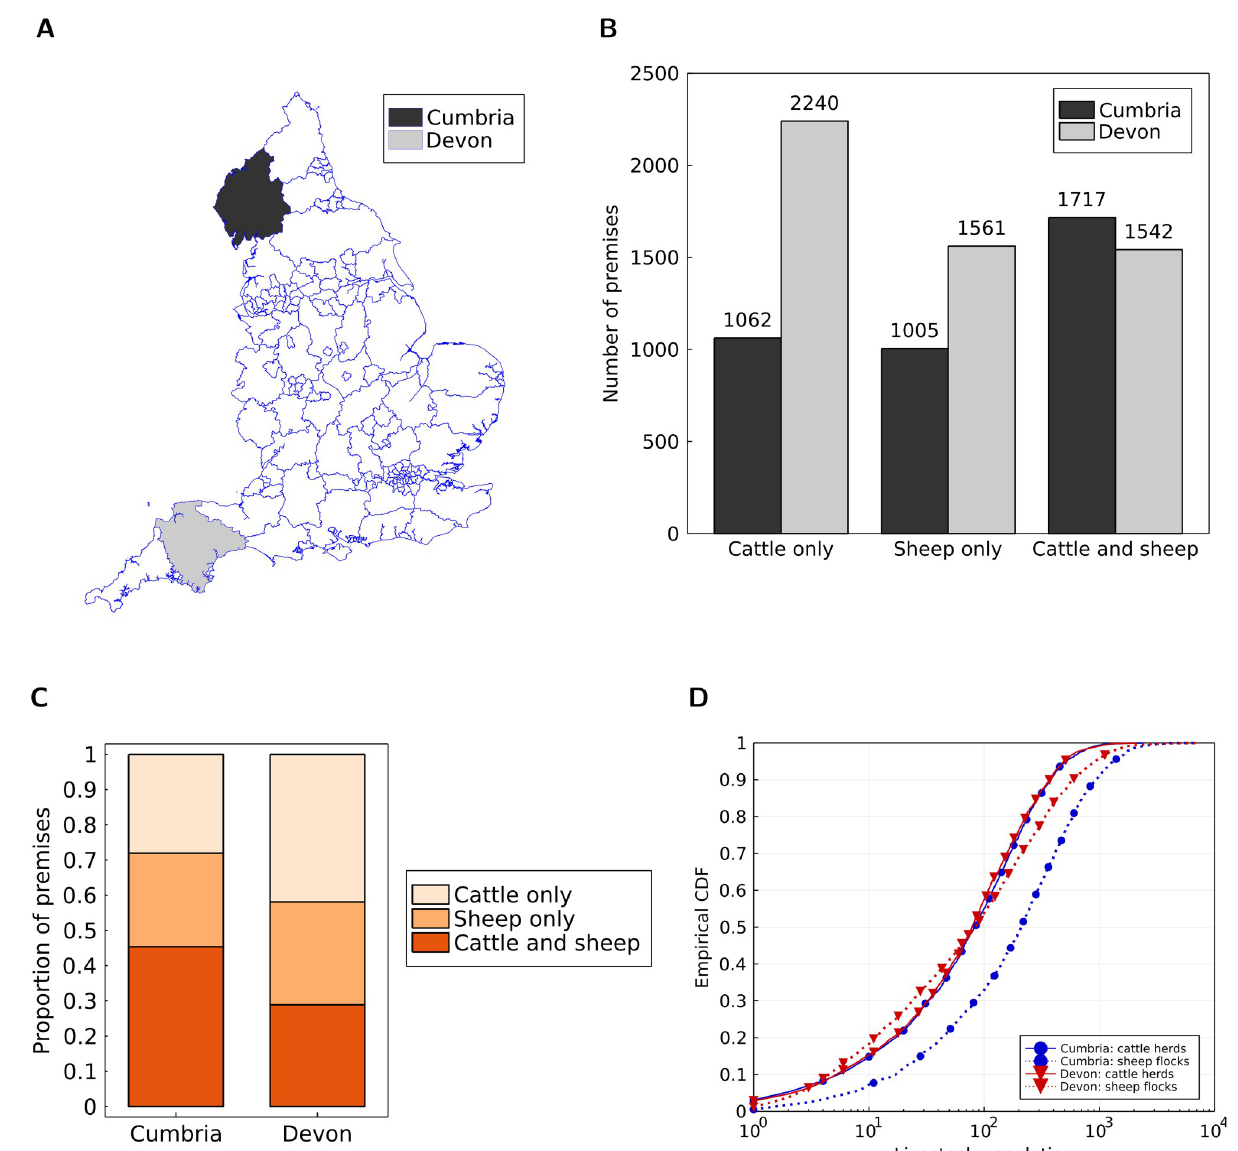
Fig 1. Livestock demographics of premises in our Cumbria and Devon county datasets. Our county datasets contained premises that had at least one positive count of cattle (estimates from the 2020 CTS data) or sheep (estimates from the December 2020 sheep inventory). A Locator map for Cumbria (shaded black) and Devon (shaded grey). The base layer of the map was made available by the Office for National Statistics [29]; URL: https://www. arcgis.com/home/item.html?id=aff50e8d15364a7b82c62c14861eb240. Source: Office for National Statistics licensed under the Open Government Licence v.3.0. Contains OS data Crown copyright and database right 2022. We display per county: B the number of premises with cattle only, sheep only or both cattle and sheep; C the proportion of premises with cattle only, sheep only or both cattle and sheep. D Empirical cumulative distribution functions of cattle herd size (solid lines) and sheep flock size (dashed lines) for Cumbria (blue lines with circle markers) and Devon (red lines with inverted triangle markers). In panel D , we limited the calculation of the empirical cumulative distribution functions to only include premises where the given livestock type (cattle or sheep) was